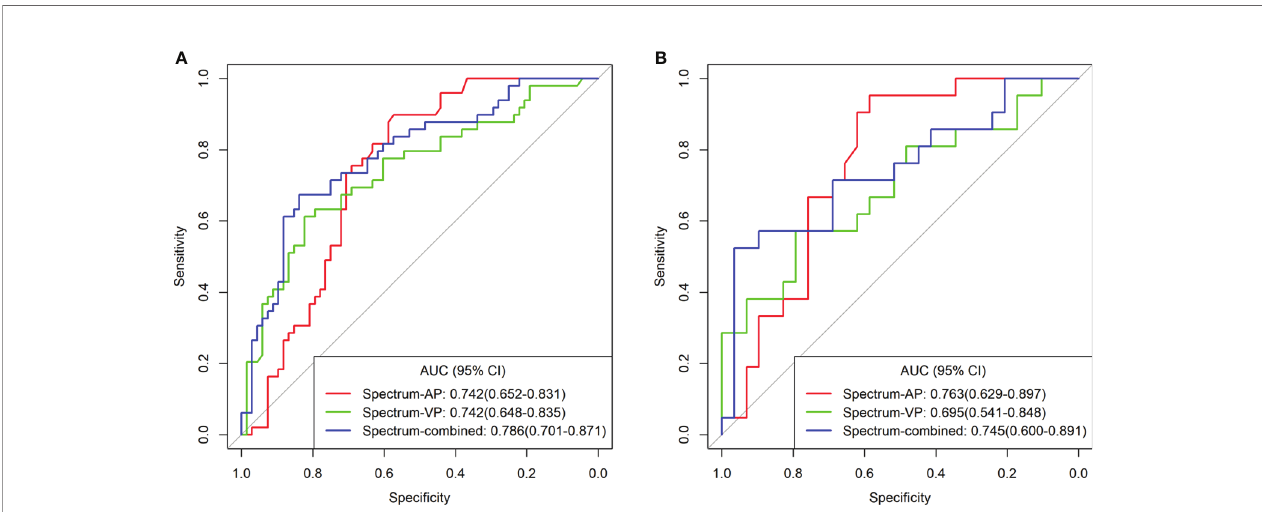
FIGURE 4 | Comparison of the different spectrum models for the identi fi cation of LNM in patients with colorectal cancer in the training cohort (A) and validation cohort (B)